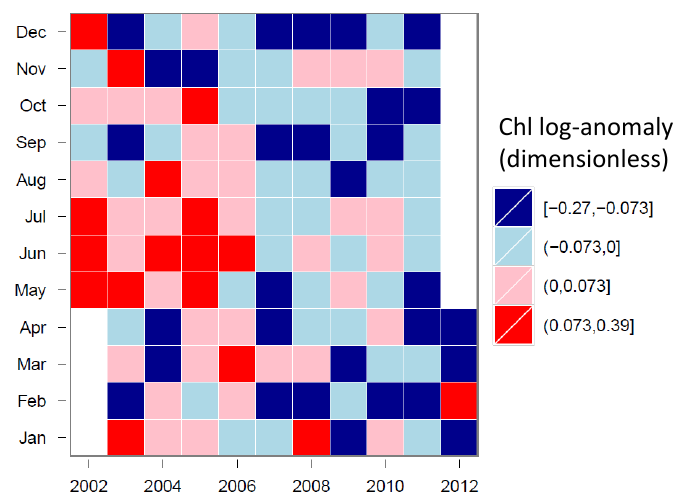
Figure 11. Tile-plot of Chl for the VDG cluster